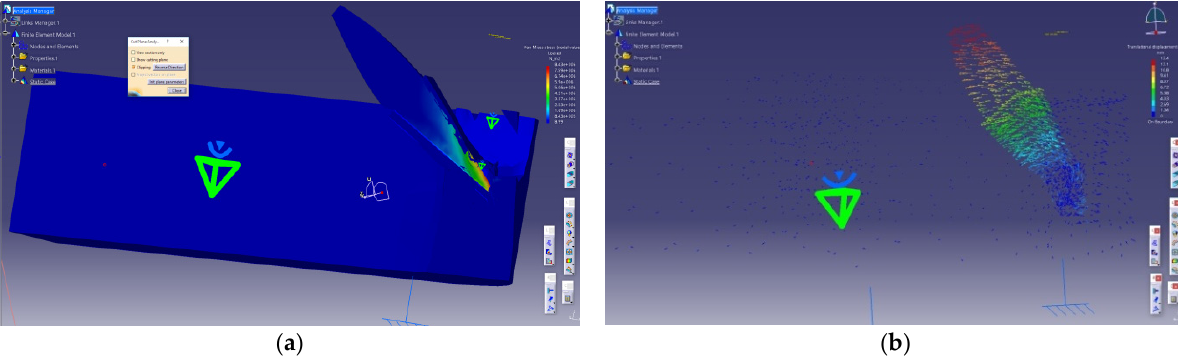
Figure 7. Lingualization of the LCI using a 3 N force: ( a ) von Mises tensions, 66% HBL; ( b ) tooth movement, 66% HBL.